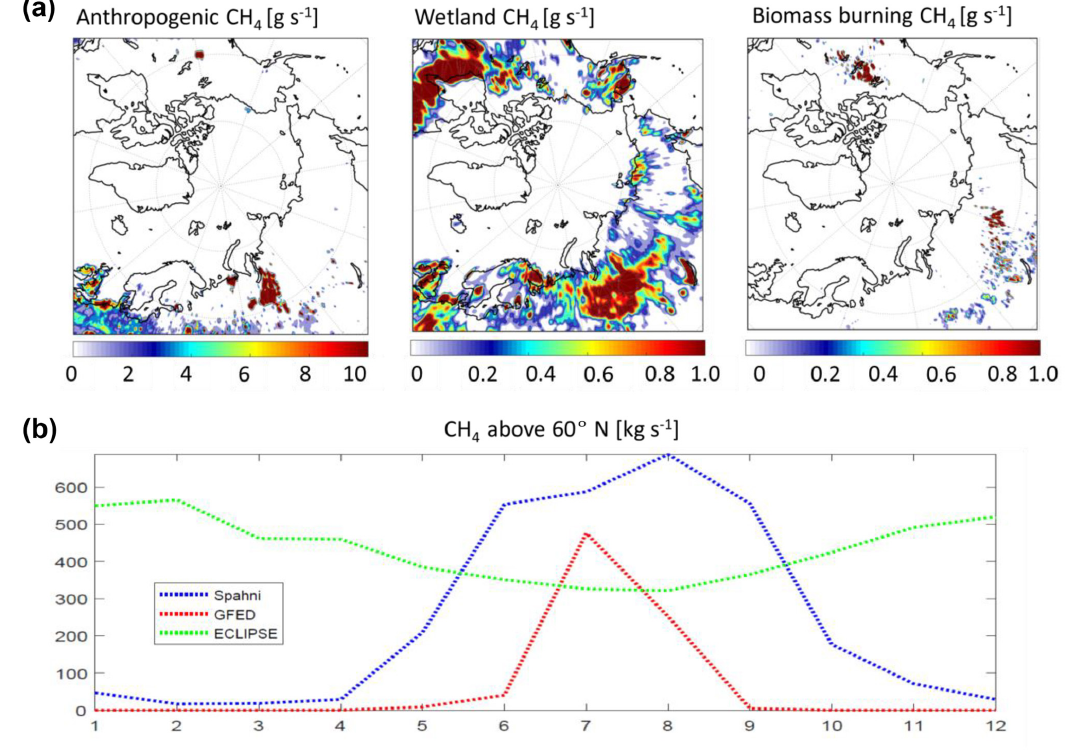
Figure 4. (a) Annual average high-latitude CH 4 emissions from anthropogenic sources, wetlands, and biomass burning according to GAINS ECLIPSE (Stohl et al., 2015; http://www.iiasa.ac.at/web/home/research/researchPrograms/air/ECLIPSEv5a.html, last access: 21 Novem- ber 2018), LPX-Bern (Spahni et al., 2011; Stocker et al., 2014; http://www.climate.unibe.ch/), and the Global Fire Emissions Database, GFED (Randerson et al., 2017), respectively. (b) Monthly variation in anthropogenic, wetland, and biomass burning emissions above 60 ◦